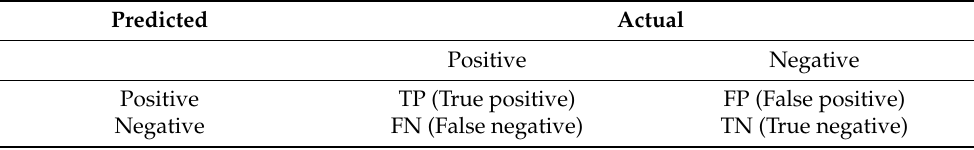
Table 1. Confusion Table 1. Confusion matrix.